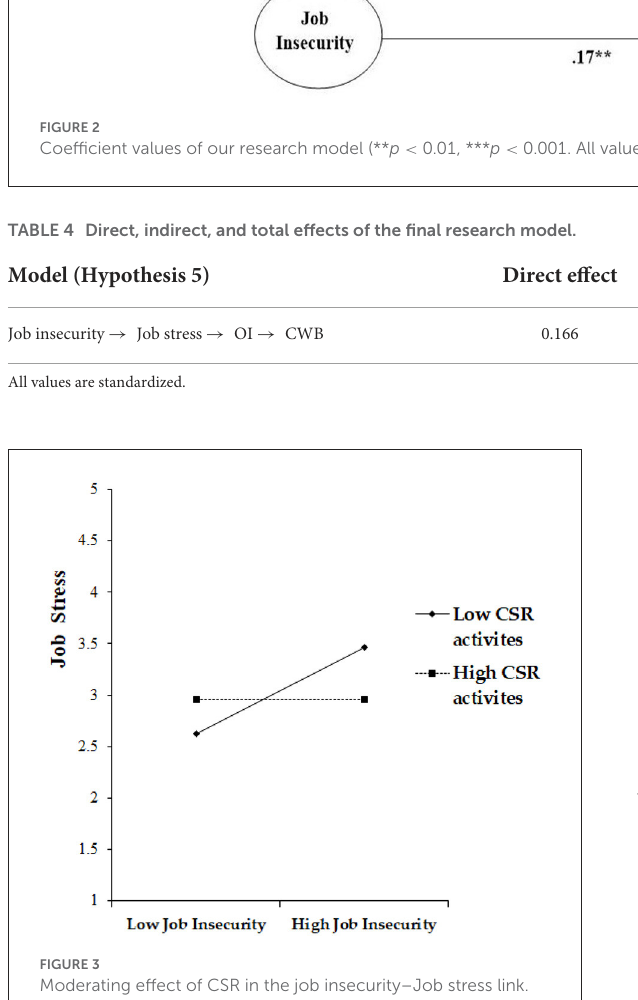
job insecurity on job stress is decreased, supporting Hypothesis 6 (please see Figure